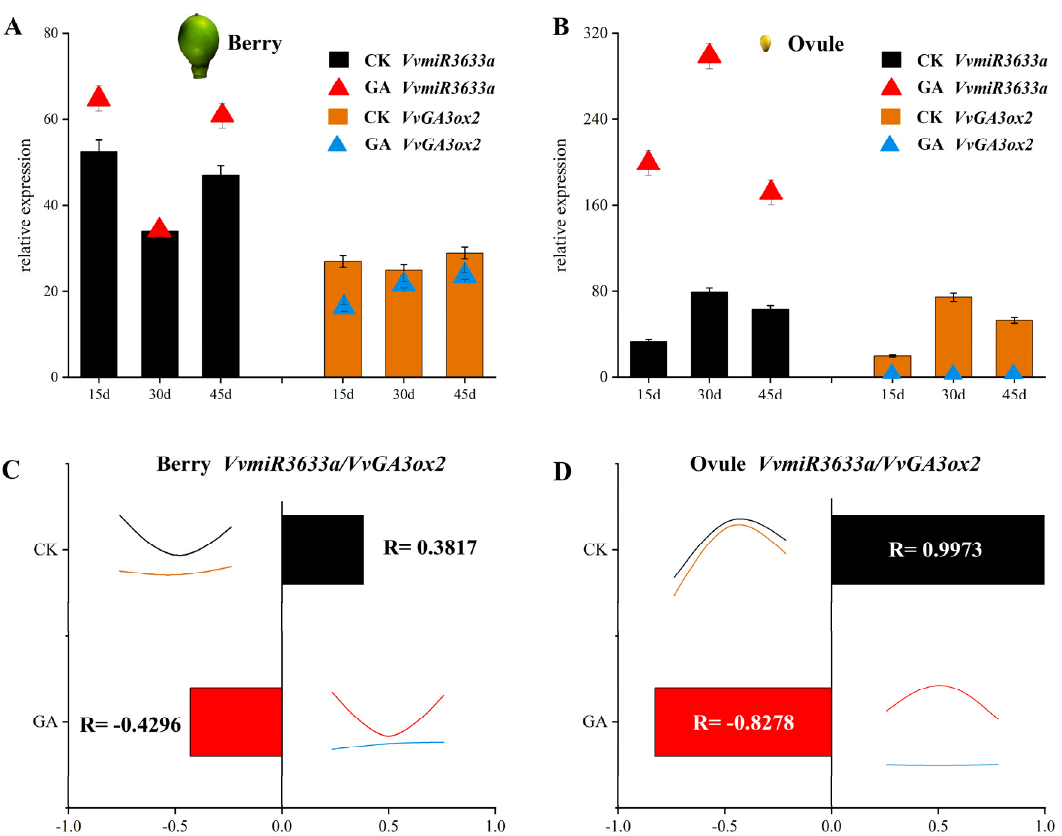
Figure 6. Expression analysis and correlation of miR3633a-GA3ox2 module in response to GA in berries ( A , C ) and ovules ( B , D